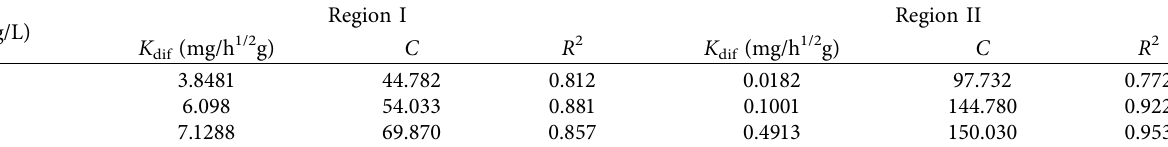
− sorption by ZCOBLP. 4